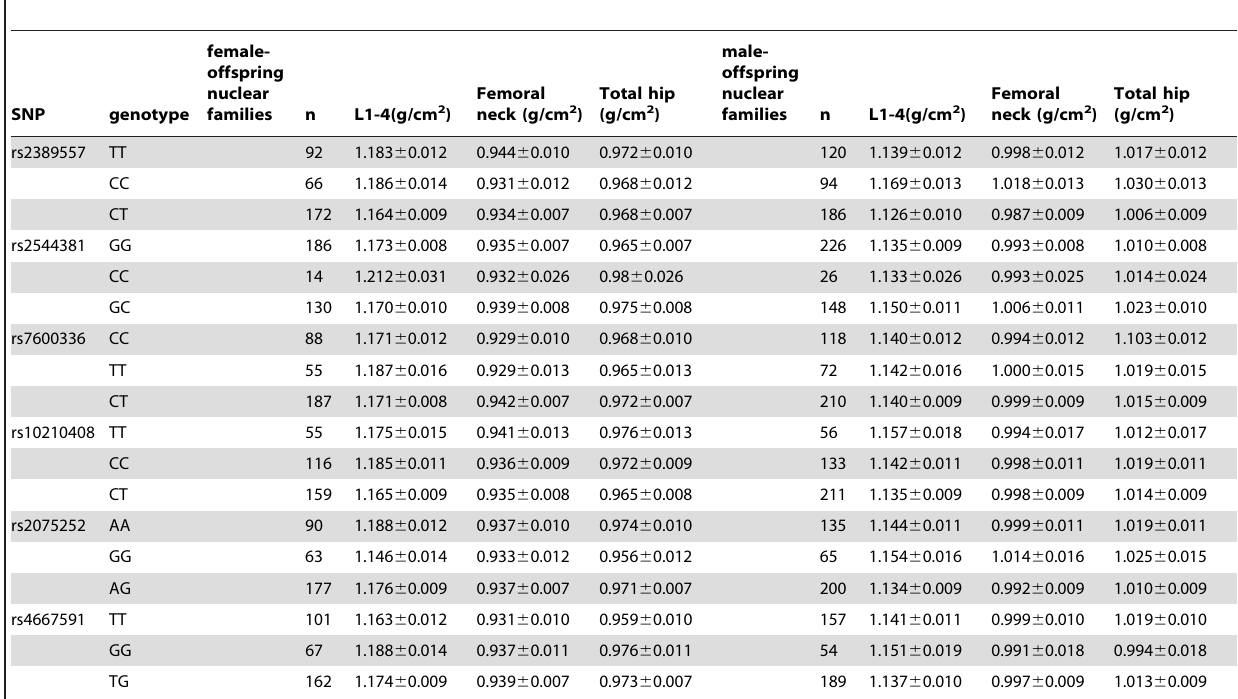
Table 2. Peak BMD phenotypes and genotypes in 330 unrelated daughters and 400 unrelated adult sons from the studied nuclear